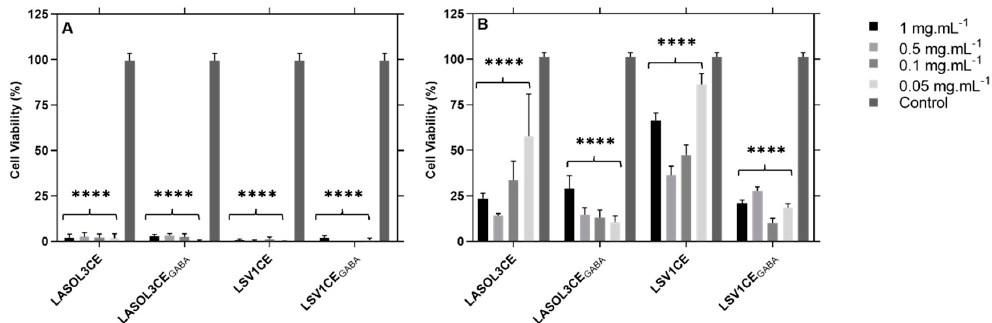
Figure 3. Cytotoxicity of crude extracts from L. theobromae LA-SOL3 and LS-V1, grown in the presence (i.e., LA-SOL3CE GABA and LA-SV1CE GABA ) and absence of 10 mM of γ -aminobutyric acid (i.e., LA-SOL3CE and LA-SV1CE) in 3T3 cells ( A ) and Vero cells ( B ). Phosphate Buffered Saline (PBS) was used as control. Statistical analysis was performed using two-way ANOVA, followed by a Tukey multiple comparison test. Asterisks correspond to data with statistical difference (**** p < 0.0001) to the control.